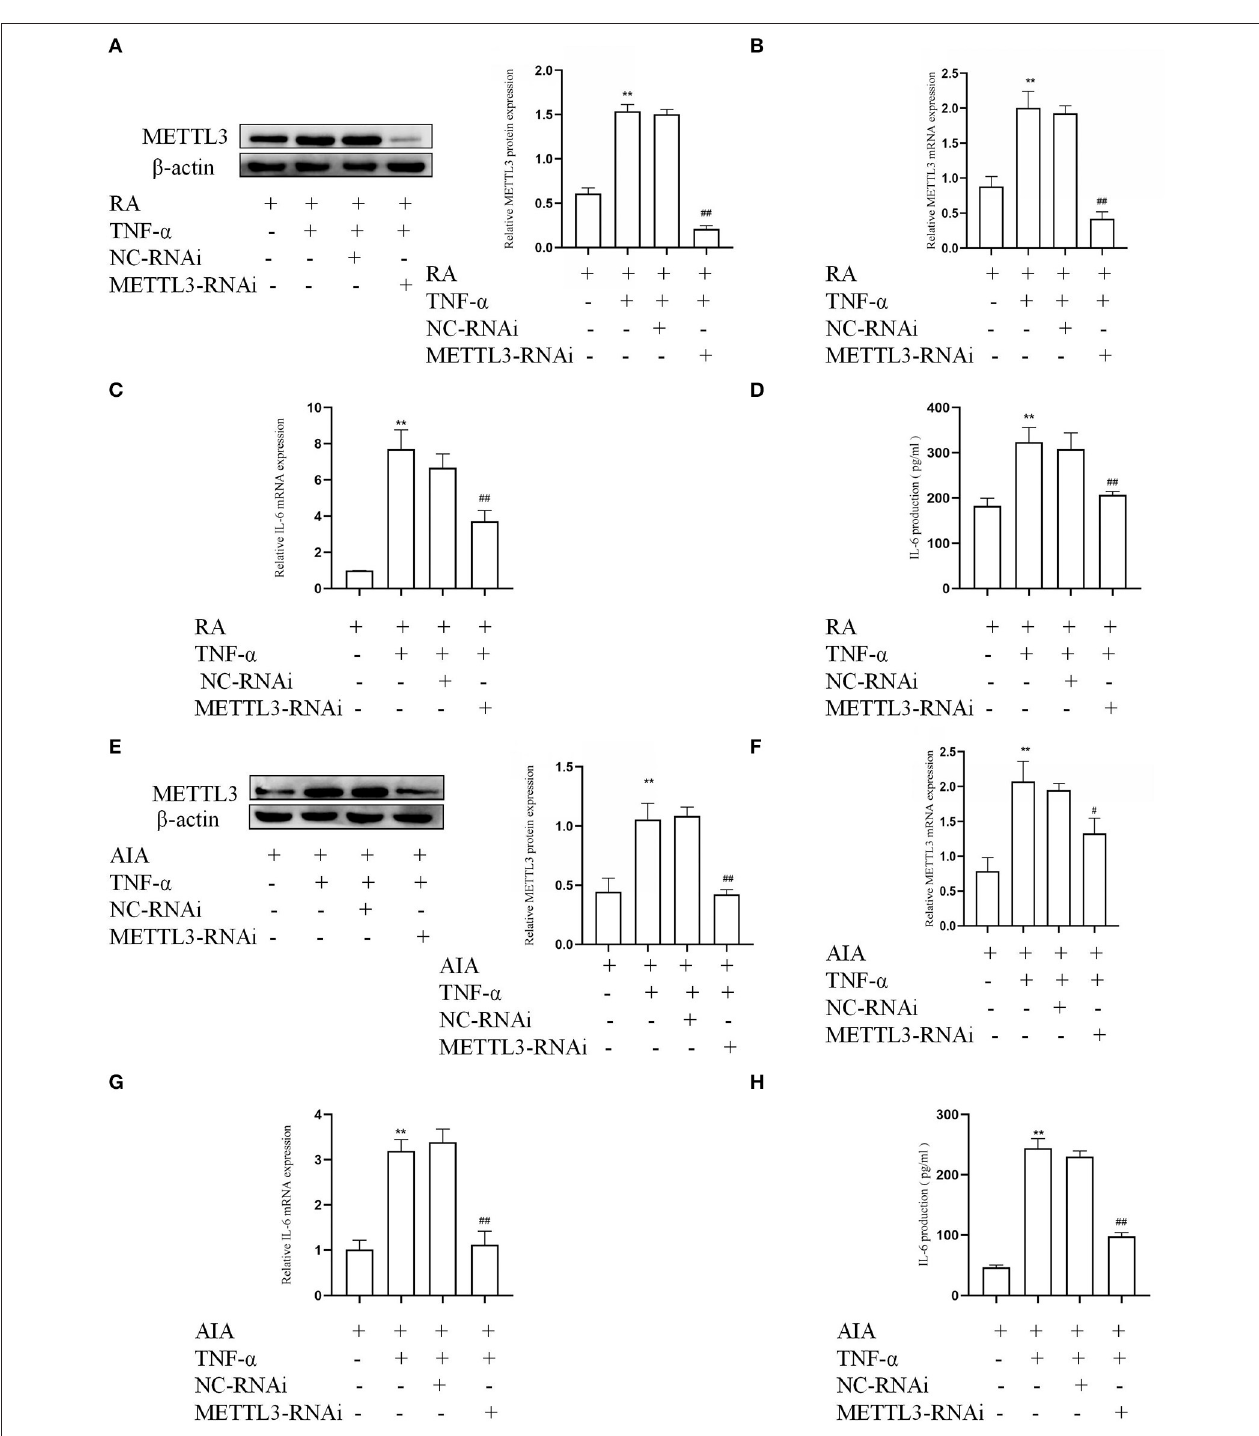
FIGURE 3 | Methyltransferase-like 3 (METTL3) knockdown (using METTL3 siRNA) inhibits inflammatory cytokines in human and rat fibroblast-like synoviocytes (FLSs). (A) METTL3 protein levels in TNF- α -treated rheumatoid arthritis (RA)-FLSs after METTL3 knockdown, as detected by Western blotting. (B) METTL3 mRNA levels in TNF- α -incubated RA-FLSs after METTL3 silencing, as detected by real-time quantitative PCR (qPCR). (C) IL-6 mRNA levels in TNF- α -incubated RA-FLSs with METTL3 knockdown, as detected by qPCR. (D) The number of IL-6 in TNF- α -incubated RA-FLS supernatants were analyzed by ELISA. (E) Western blotting was used to measure METTL3 protein levels in TNF- α -incubated AIA-FLSs with METTL3 siRNA. (F) METTL3 mRNA levels in TNF- α -incubated AIA-FLSs after using METTL3 siRNA, as detected by qPCR. (G) IL-6 mRNA levels in TNF- α -incubated AIA-FLSs with METTL3 knockdown, as detected by qPCR. (H) ELISA was used to detect the production of IL-6 in TNF- α -incubated AIA-FLS supernatants. All of these values are presented as the mean ± SD. NC , negative control. ** P < 0.01 vs. the control group. # P < 0.05, ## P < 0.01 vs. the NC group.